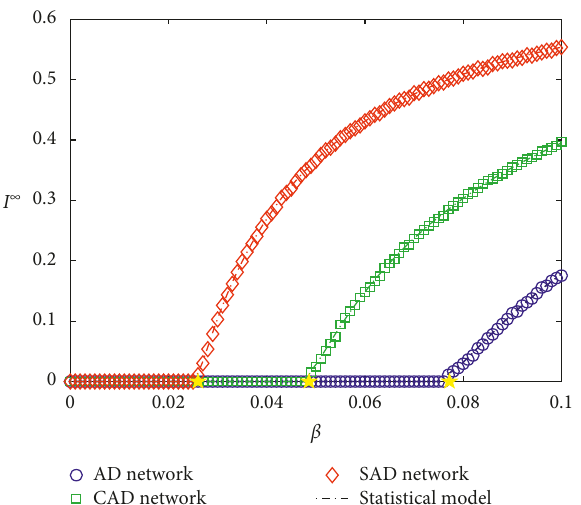
Figure 6: The final fraction of infectious nodes as a function of the infection rate β in AD networks, CAD networks, and SAD networks. Here, we chose p � 0 . 5 for the CAD networks to illustrate the theoretical results of equation (35). The epidemic thresholds suggested by the Monte Carlo simulations, the statistical model, and the theoretical analysis are recorded and labeled following the same step as in Figure